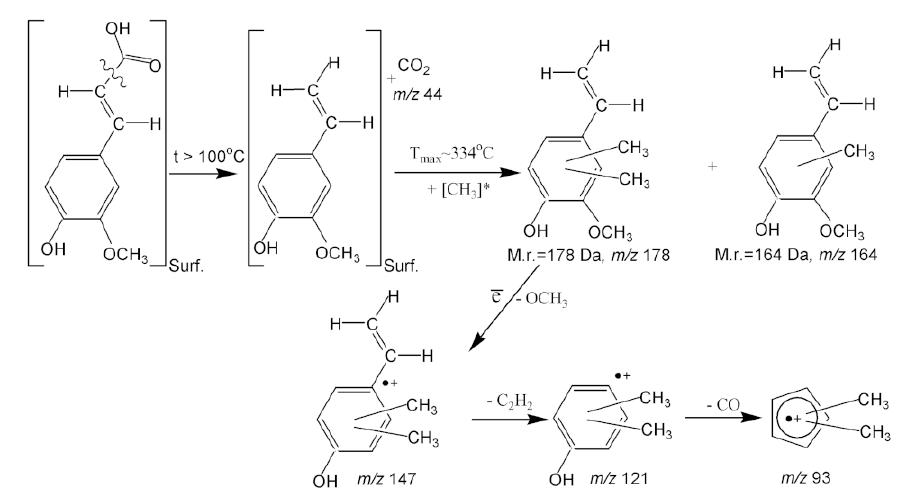
Scheme 8. The methylated 4-vinylguaiacols